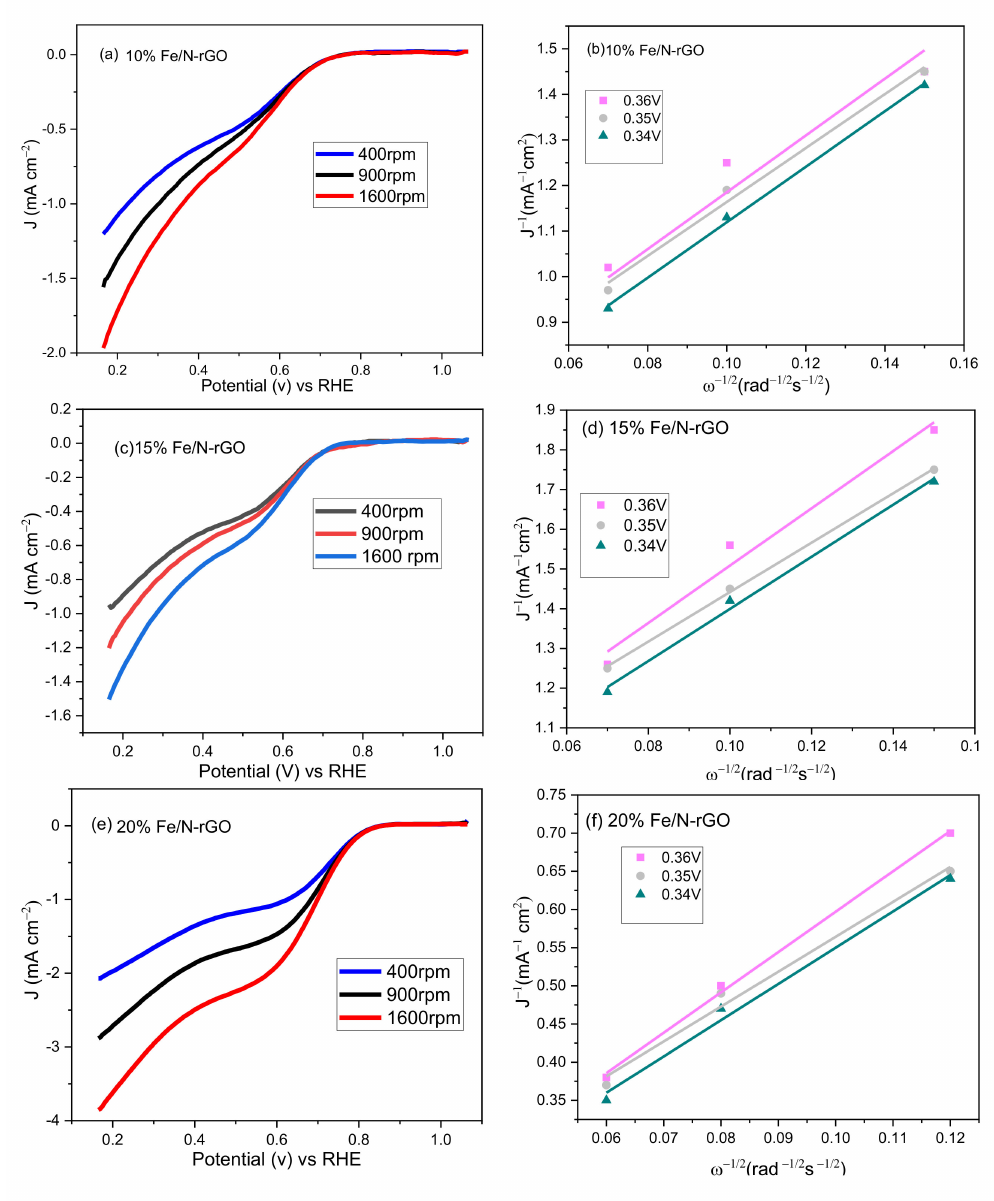
Figure 5. ( a , c , e ): Rotating disk electrode (RDE) measurement of the oxygen reduction reaction (ORR) of Fe/N-rGO catalyst with Fe loadings of 10%, 15% and 20% in O 2 -saturated 0.1 M KOH, respectively. ( b , d , f ) Corresponding Koutecky–Levich plots at 0.34, 0.35 and 0.36 V (vs. RHE), respectively. At 1600 rpm, 20% Fe/N-rGO exhibited the highest onset potential of 0.84 V (vs.